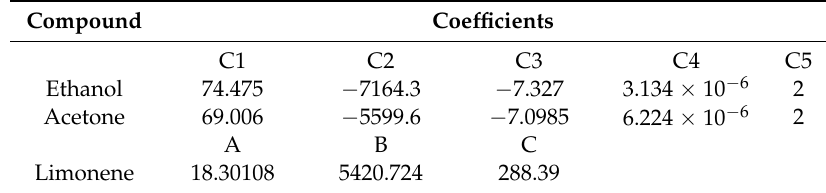
Table 3. Coefficients for the calculation of the vapor pressures of Ethanol, Acetone, and Limonene [46].